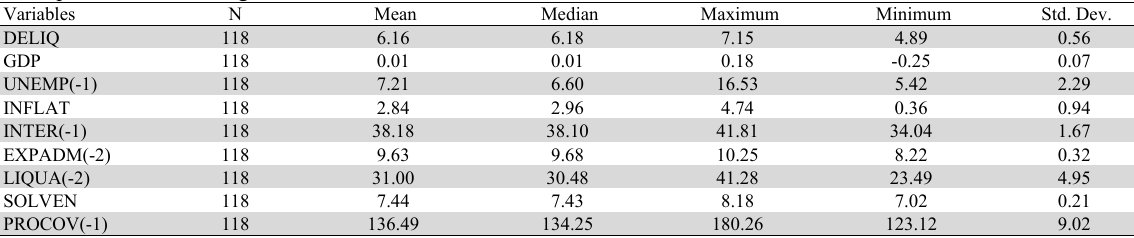
Descriptive statistics of significant